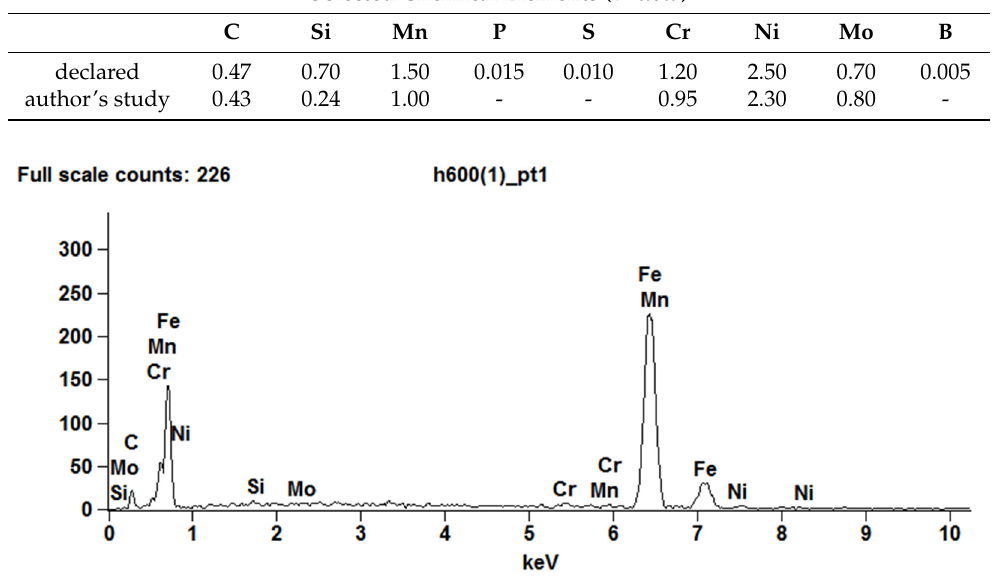
Figure 5. X-ray energy spectrum of Hardox 600 steel. Figure 5. X ‐ ray energy spectrum of Hardox 600 steel. The low contains the elements Cr (approx. 1%) and Mn (approx. 1.2%), causing